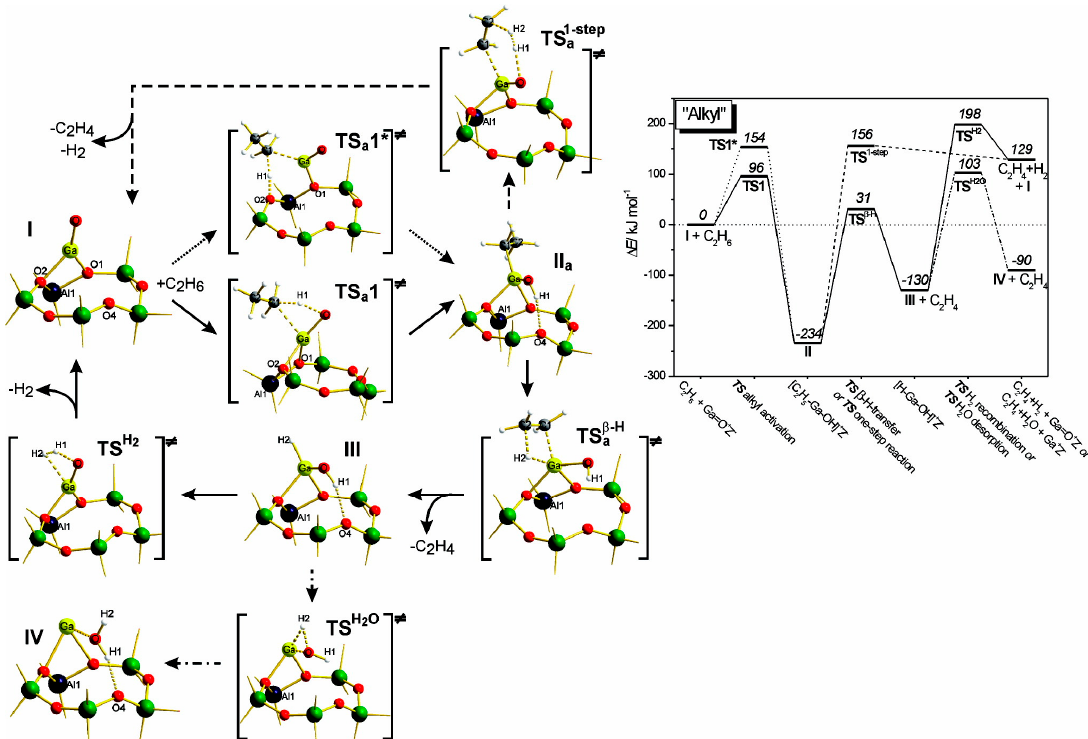
Figure 12. Reaction route for “carbenium” activation of ethane on [GaH 2 ] + . Reprinted with permis- sion from ref [117]. Copyright 2000 American Chemical Society.